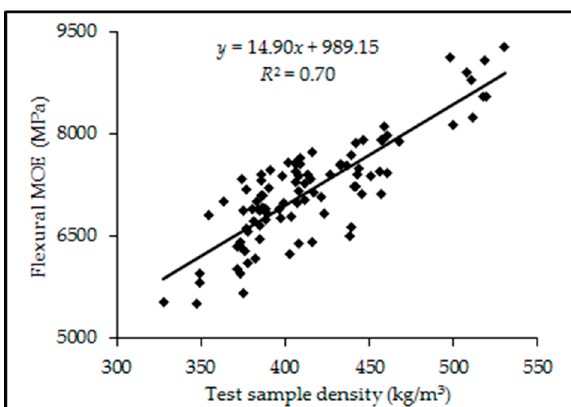
Figure 3. Relationship between test sample density and flexural modulus of elasticity.